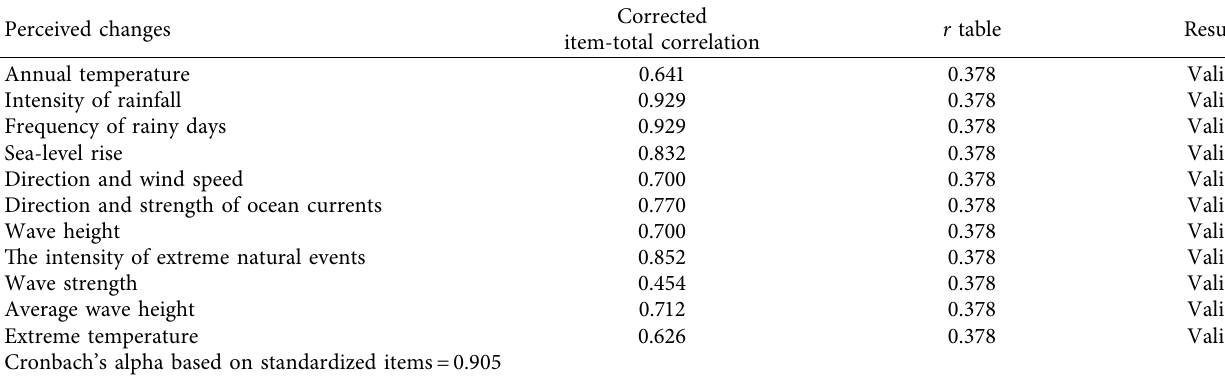
Figure 3: Schematic presentation of the sampling procedure. Table 1: Validity and reliability results of climate change